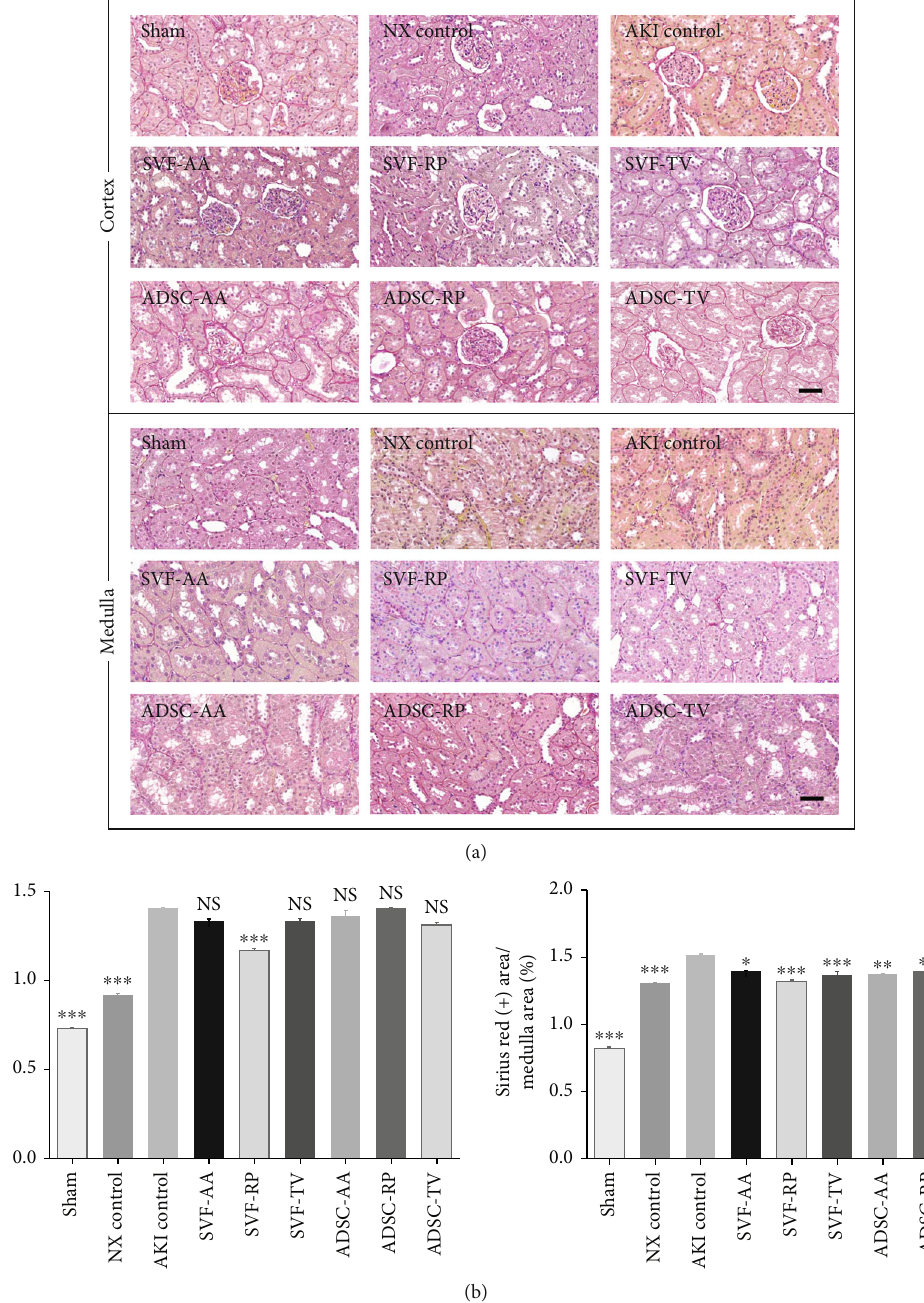
Figure 4: Sirius red staining of kidney tissue. (a) Representative photomicrographs of cortex and medulla. (b) Ratio of area stained positive for Sirius red to random cortex area (left) and medulla area (right). Magni fi cation × 40. Scale bar 50 μ m. NS, p > 0 : 05 ; ∗ p < 0 : 05 ; ∗∗ p < 0 : 01 ; ∗∗∗ p < 0 : 001 compared to the AKI control group. 4 fi elds per rat; 10 rats per group, but 8 rats in the SVF-AA and ADSC-AA